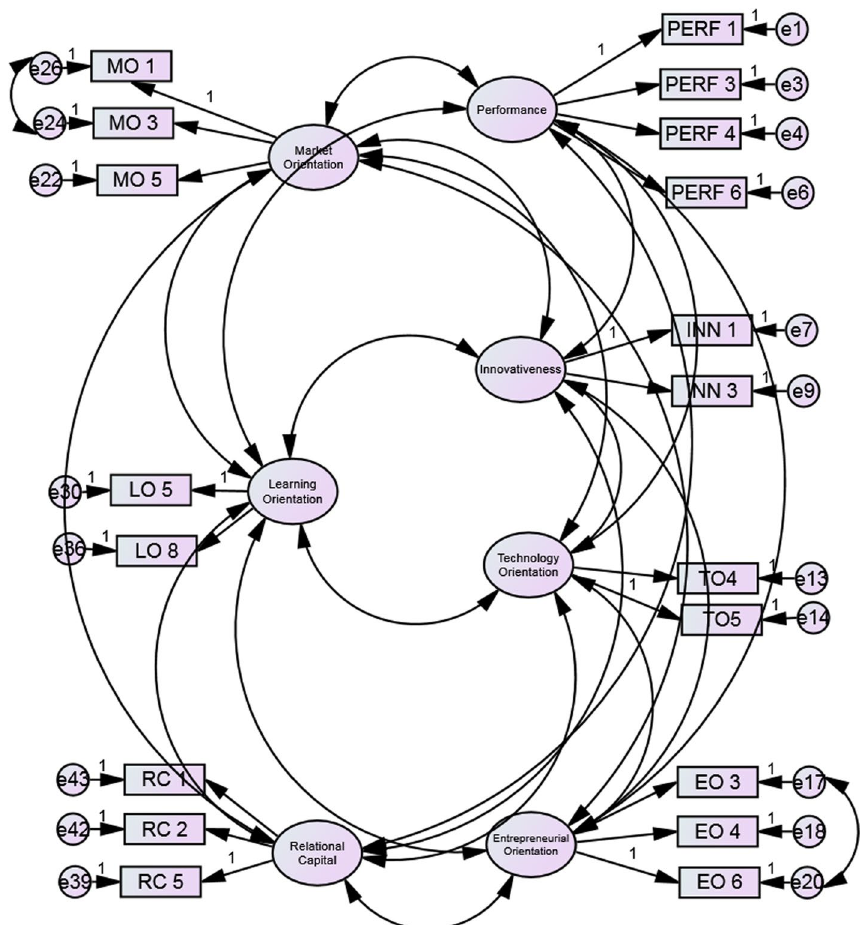
Fig. 2 Confirmatory factor analysis for the proposed model. Source: Self‑elaborated